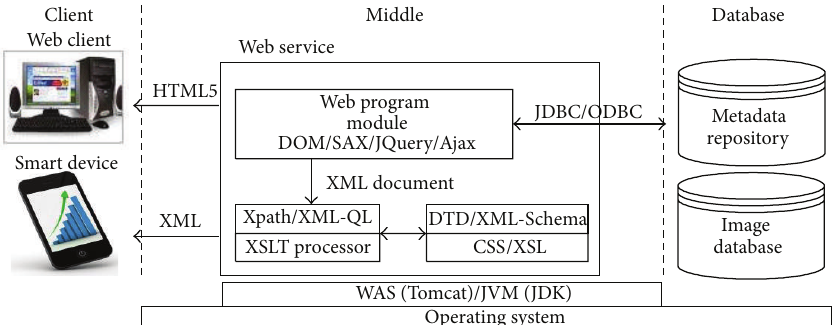
Figure 1: XML-based image metadata service architecture.